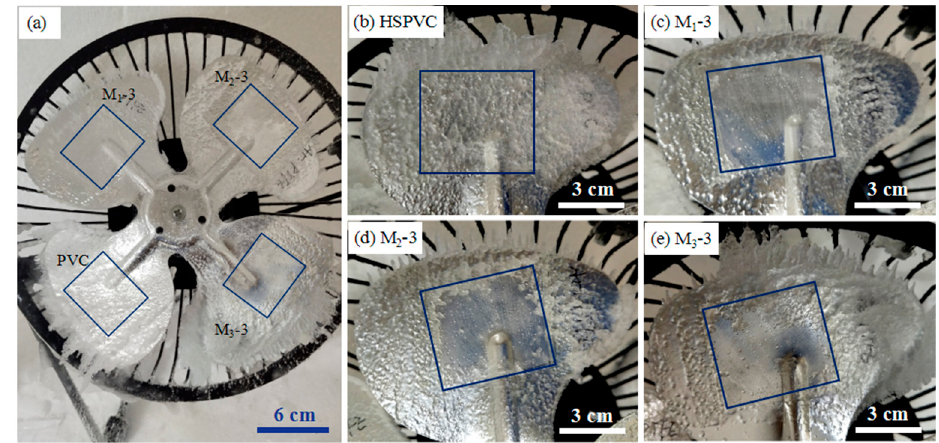
Figure 11. Dynamic icing diagrams of ( a ) electric fan, ( b ) PVC, ( c ) M 1 -3, ( d ) M 2 -3, ( e ) M 3 -3.